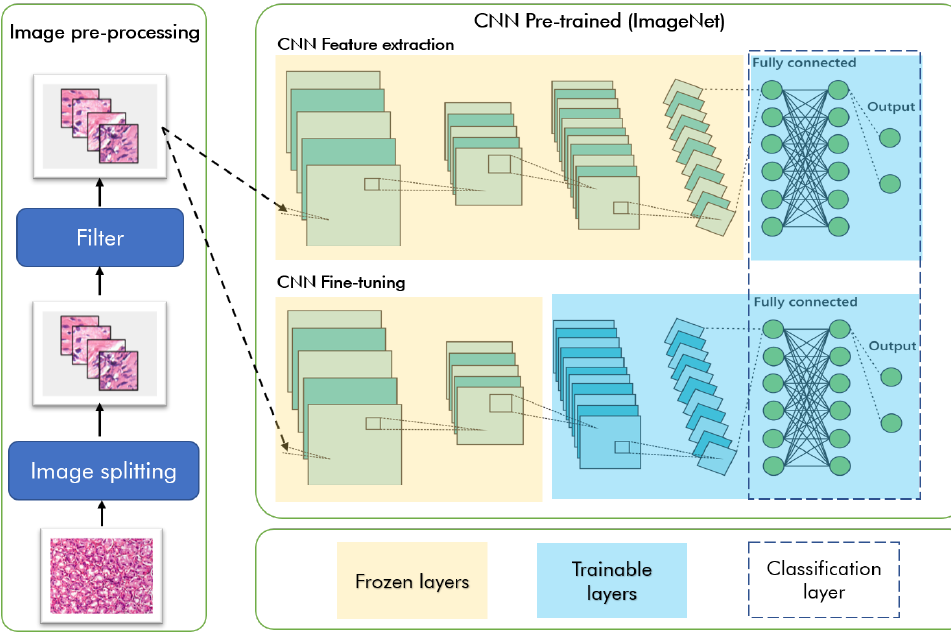
Figure 5. Overview of transfer learning approach. The frozen convolutional layers are highlighted in yellow, and the trainable layers of the models are highlighted in